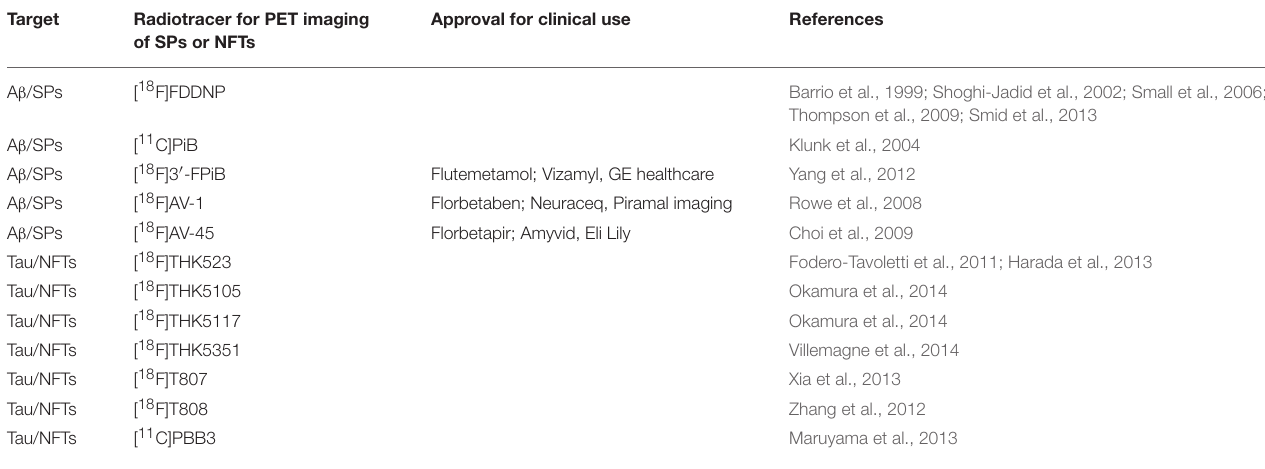
TABLE 1 | Reference list for A β and Tau PET